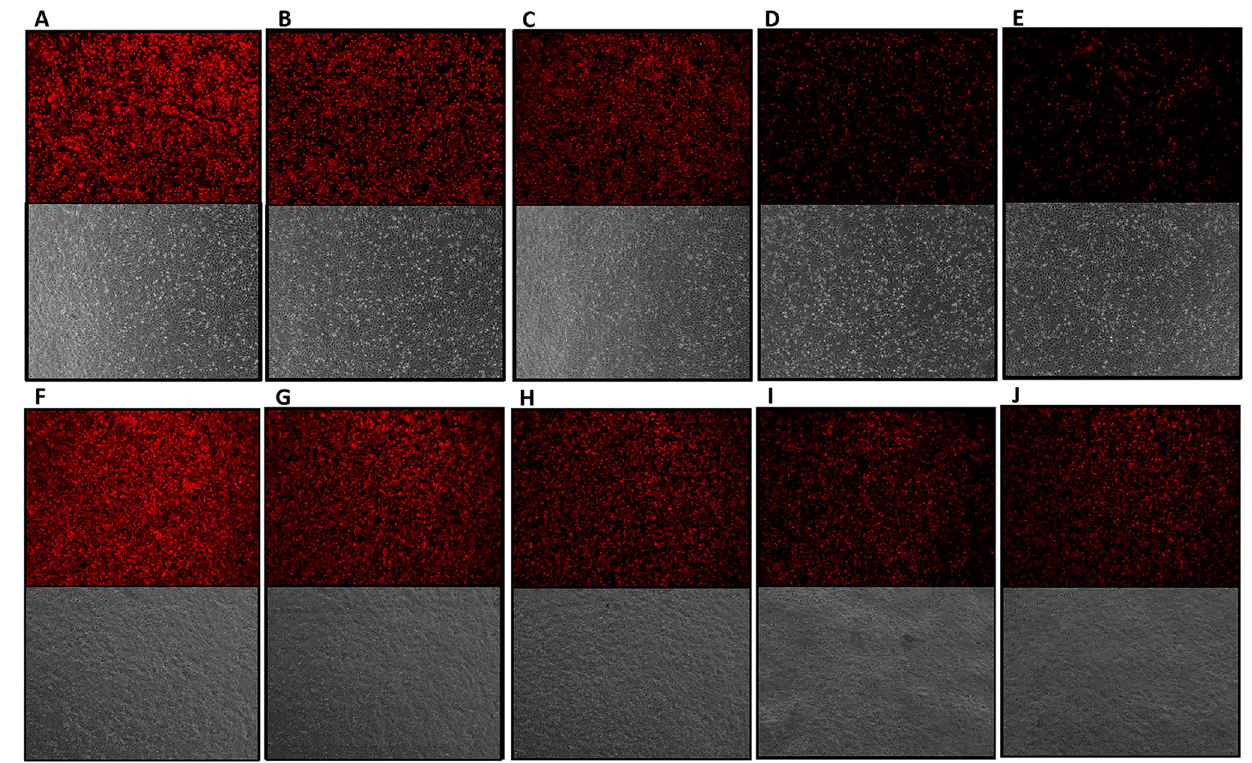
Figure 5. Comparison of fluorescence intensity of recombinant MVA viruses. DF-1 and Vero cells were infected with each recombinant virus at an MOI of 1, and at 24 h p.i., images were acquired using a 4 × objective and a Texas red filter set at 100% intensity. Row A to E corresponds to DF-1 cells, and row F to J to Vero cells. Each column corresponds to: ( A , F ) MVA-PrMVA-13.5L-p30, ( B , G ) MVA-pHyb-p30, ( C , H ) MVA-S E/L- C13L-p30, ( D , I ) MVA-PrS5E-p30, and ( E , J ) MVA-S E/L-p30. Bright-field images are also